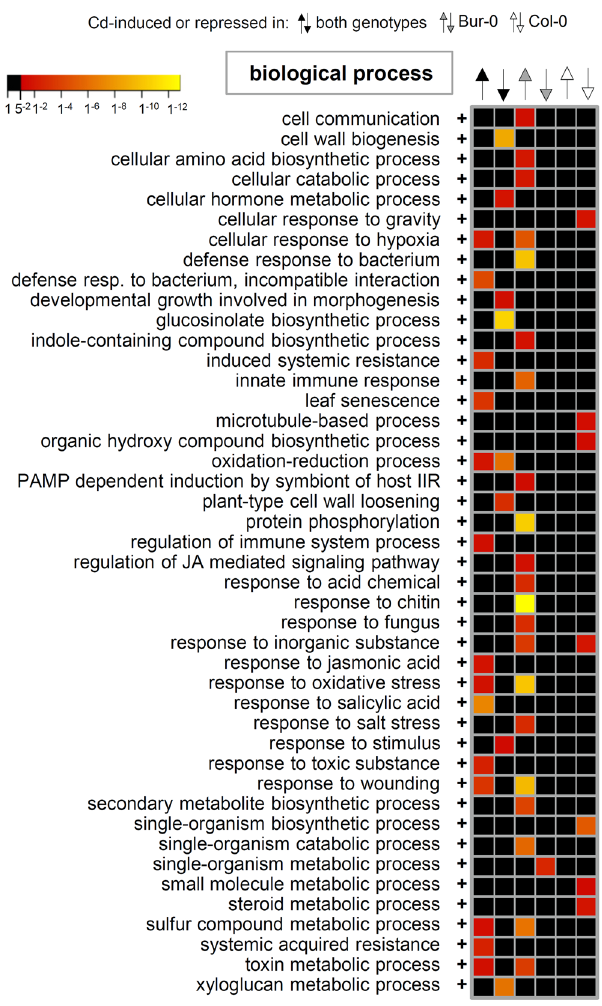
Figure 7. GO terms overrepresented in common or accession-specific Cd responses. Genes with a ≥ 2fold response ( P adj < 0.05) to Cd treatment in both accessions (black arrows for induction or repression under Cd exposure) or in only one accession (Col-0: white arrows; Bur-0: grey arrows) were selected for GO term enrichment analysis. Depicted are P adj . values (Bonferroni correction) for the most defined biological processes over-represented in at least one category; no under-representations were found (complete results of the Panther analysis can be found in Supplementary dataset